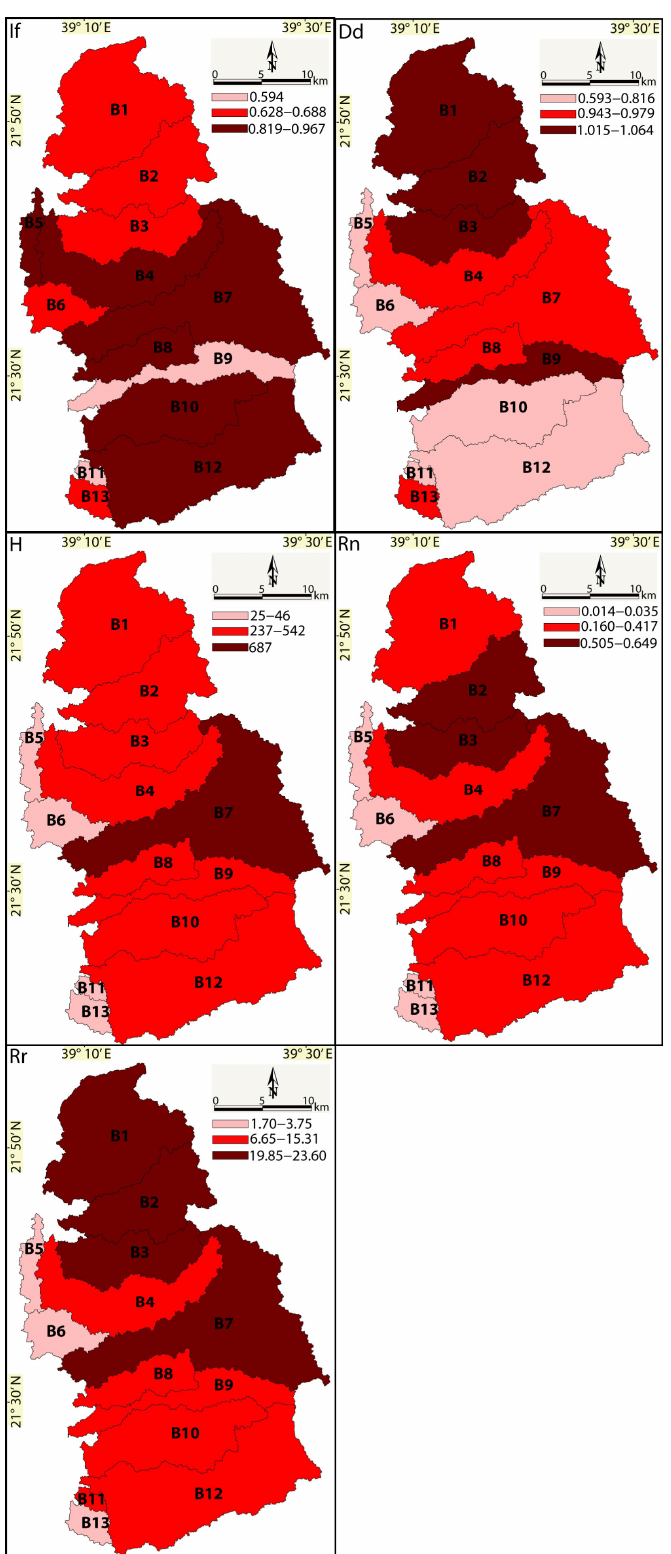
Figure 5. Models of morphometric parameters; stream number (Nu), stream length (Lu), bifurcation ratio (Rb), stream frequency (Fs), form factor (F), and texture ratio (Rt). Drainage density (Dd), infiltration ratio (If), basin relief (H), ruggedness number (Rn), and relief ratio